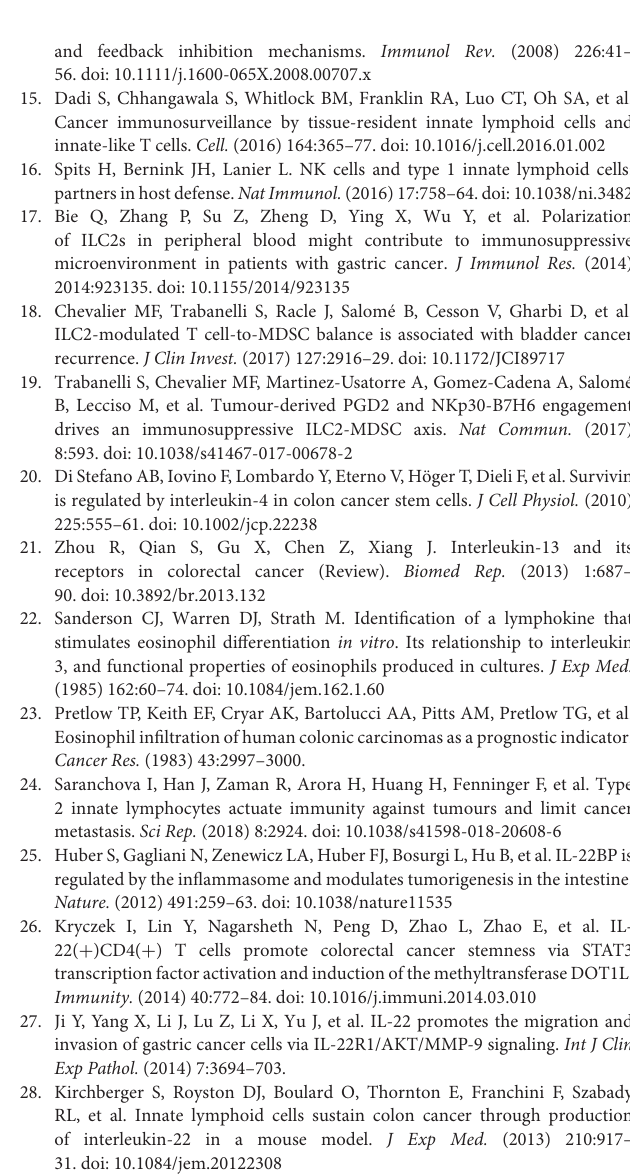
Figure S1 | Flow cytometry gating strategy and expression of transcription factors for human ILC subsets. (A) Flow cytometry gating strategy for ILC subset identifications in PBMCs of a representative HD and a representative mCRC patient. (B) Transcription factors T-bet, GATA3 and ROR γ t were assessed by intracellular staining respectively on ILC1 and CD56 + ILC1, ILC2, and ILCP.